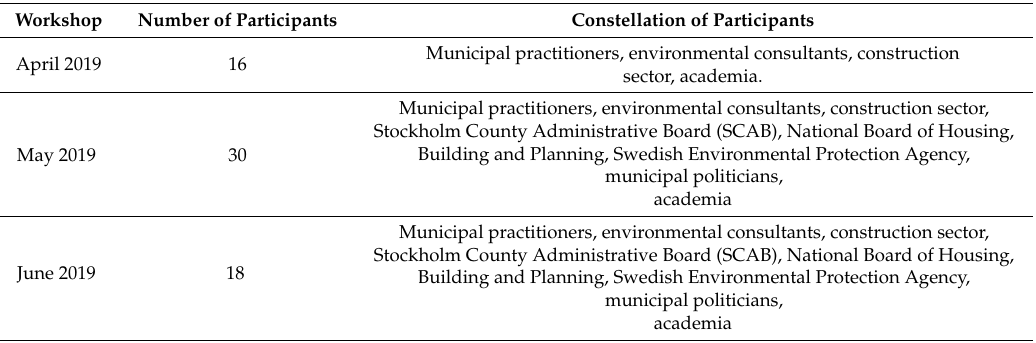
Table 2. The constellation of participants attending the workshops in April, May, and June